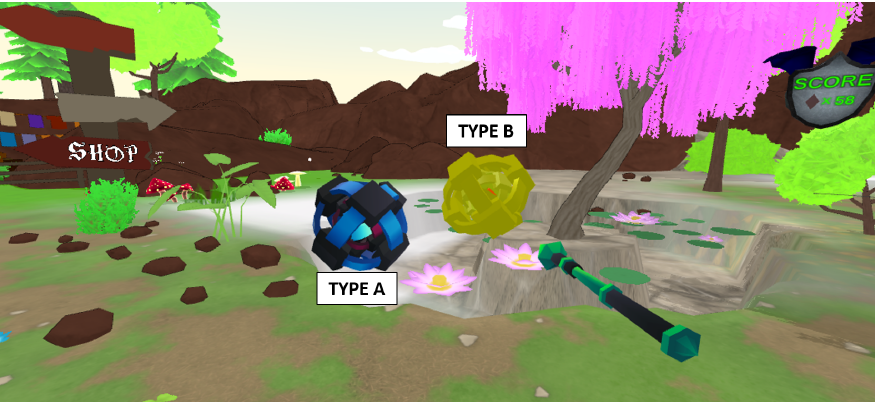
Figure 4. Mini-game one: Orb Hunt.